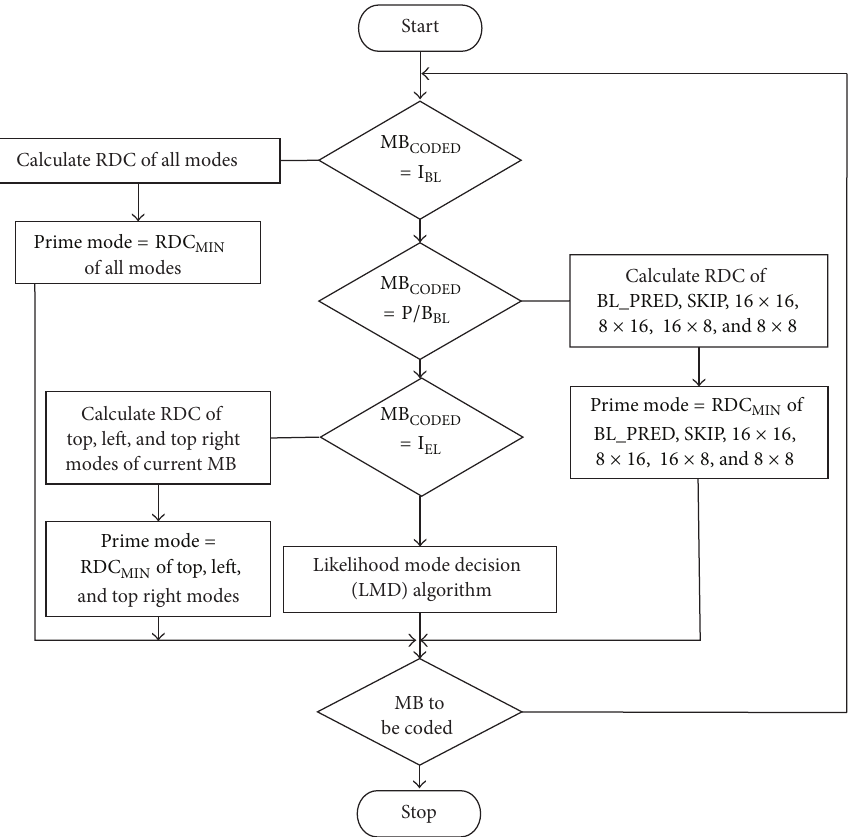
Figure 3: Flowchart of fast mode decision algorithm for SVC.